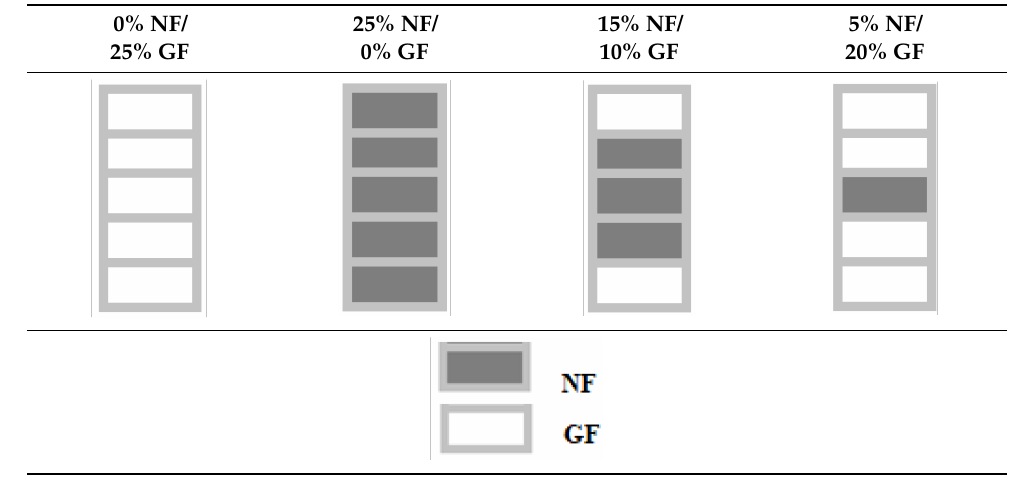
Figure 1. RTM process. Table 1. The different layer compositions in the laminated hybrid